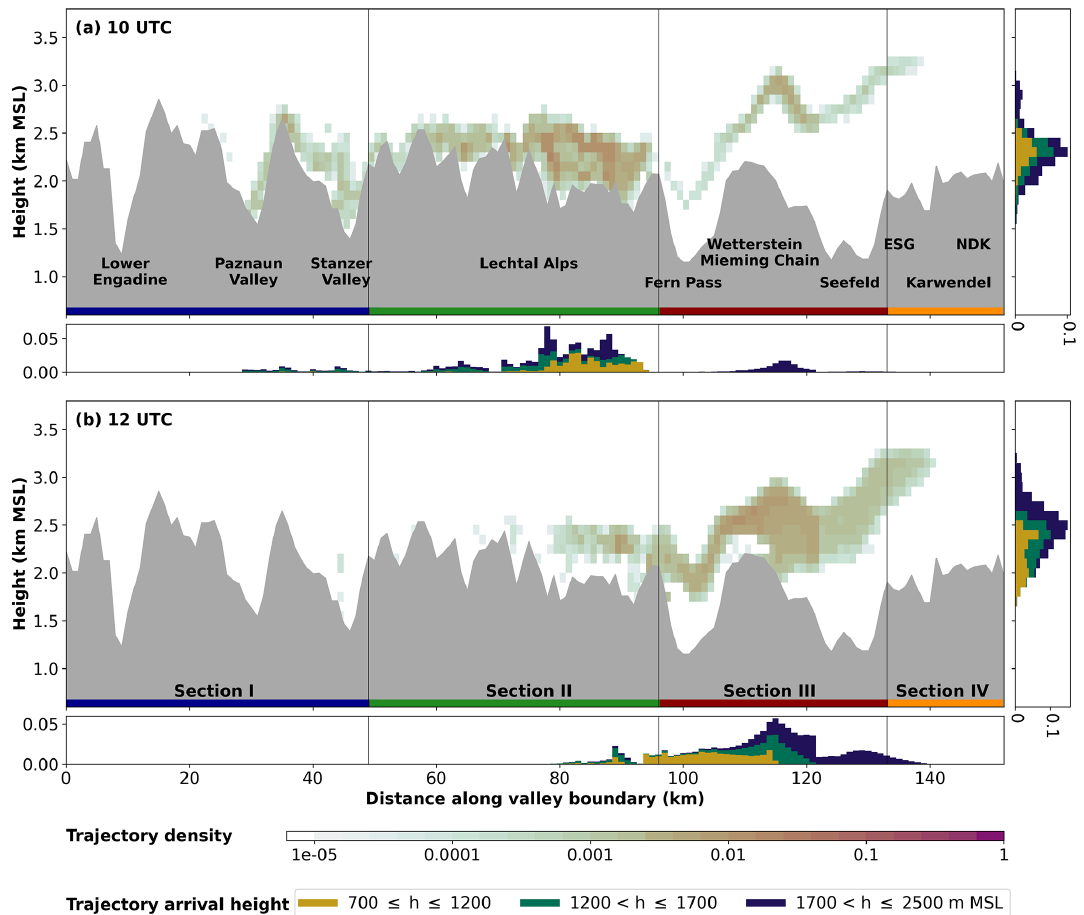
Figure 11. Density of trajectories crossing the Inn Valley boundary (see line IVB in Fig. 1b) through various different sections. Shown is the density on transect IVB for trajectories arriving in Innsbruck at (a) 10:00UTC and (b) 12:00UTC on 29 October 2017. Color contours indicate the fraction of all trajectories passing through a vertical rectangle with 1km width and 100m height. The histogram in the lower panel (right panel) shows the horizontal (vertical) distribution of the trajectory density summed up in vertical (horizontal) direction. The three stacked bars in the histogram correspond to the fraction of trajectories arriving in Innsbruck in the three layers: 700 to 1200, 1200 to 1700, and 1700 to 2500ma.m.s.l., respectively (see legend). Four subsections of the transect as described in Sect. 2.3.2 are indicated by horizontal color bars and are separated by vertical black lines. Important terrain features are named in (a)